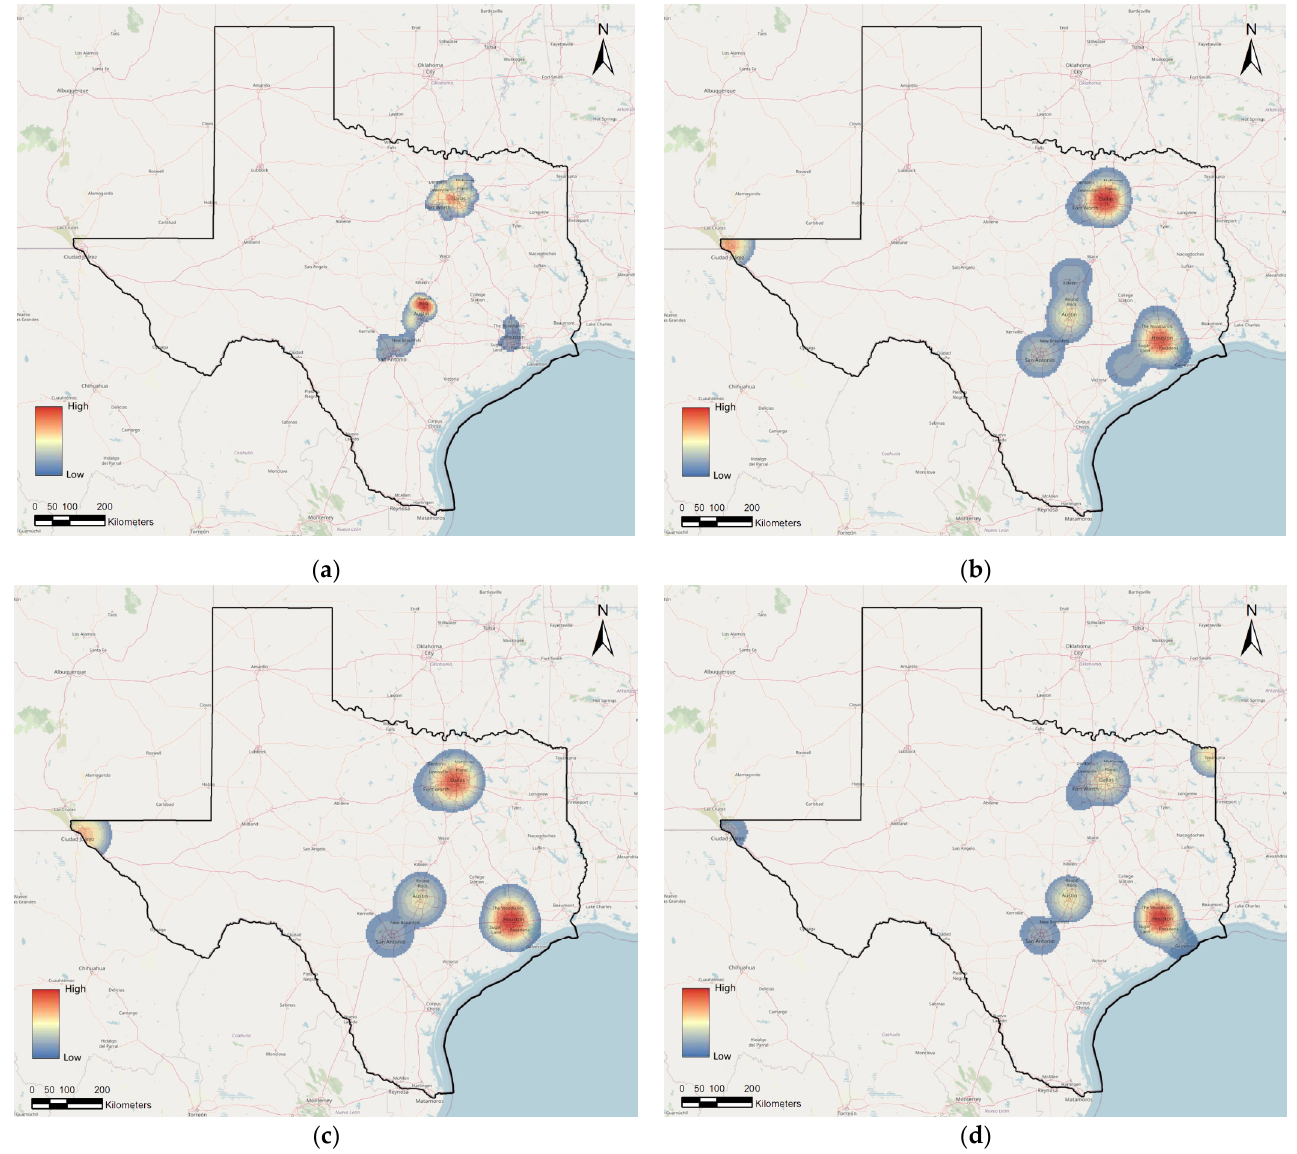
Figure 6. Spatial distribution density of different green building certification levels: ( a ) Certified, ( b ) Silver, ( c ) Gold, and ( d ) Platinum.